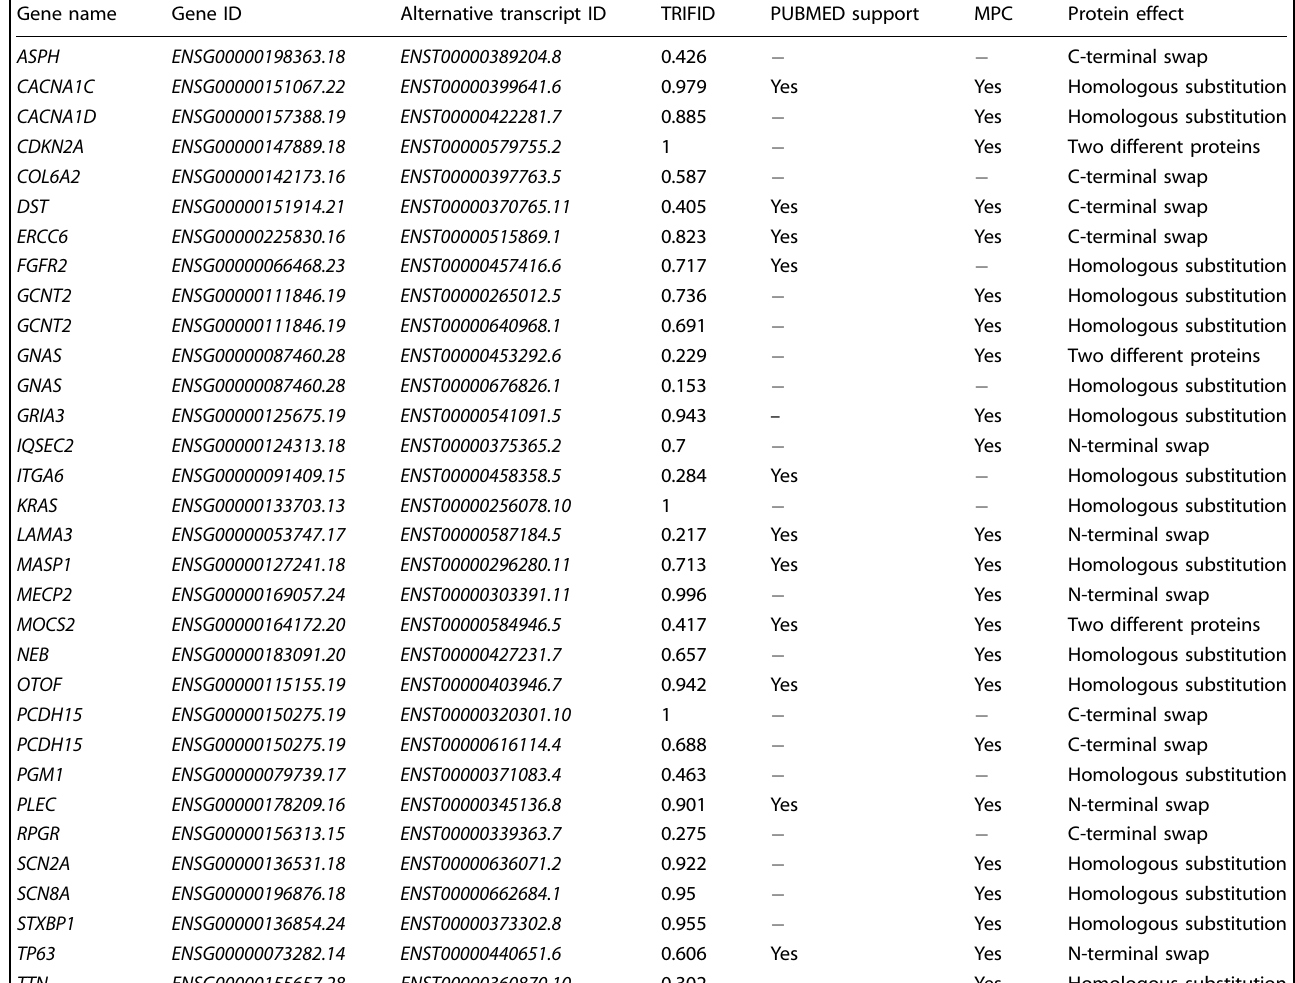
Table 1. List of human alternative transcripts that harbour validated pathogenic